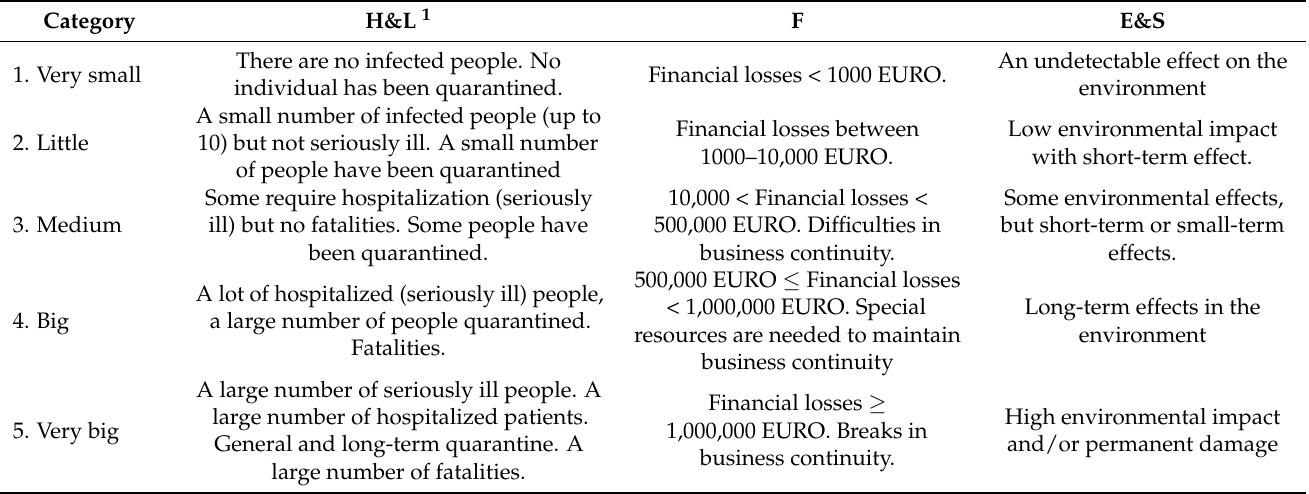
Table 2. The consequences scale. Source: Own